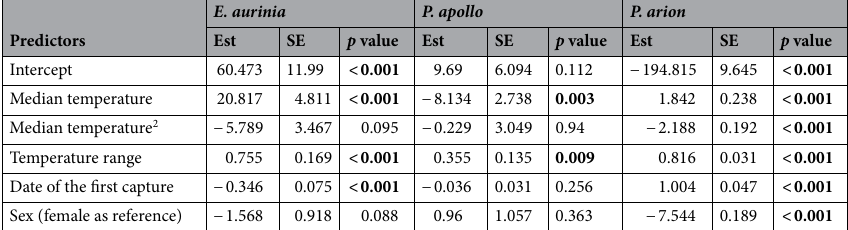
Table 3. Associations of individual variation in lifespan with thermal utilization and date of the first capture in three butterfly species. Lifespan is inferred from retention time in the population. Thermal utilization is inferred from the median and the range (max–min) of ambient temperatures, respectively, at the time of collection. Data for (a) Marsh Fritillary ( Euphydryas aurinia ), (b) Apollo ( Parnassius apollo , and (c) Large Blue ( Phengaris arion butterfly individuals captured on at least three separate days. Both linear (temperature) and nonlinear (quadratic, temperature 2 ) associations with median temperature were evaluated. Estimate, CI, and p values from a GLM with Gaussian error structure. Significant values are in